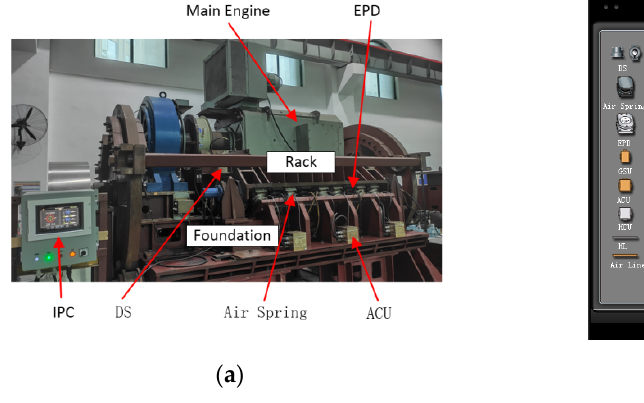
Figure 4. Experiment device: ( a ) Physical diagram of HPDME-ASVIS; ( b ) Human interaction of the control system.